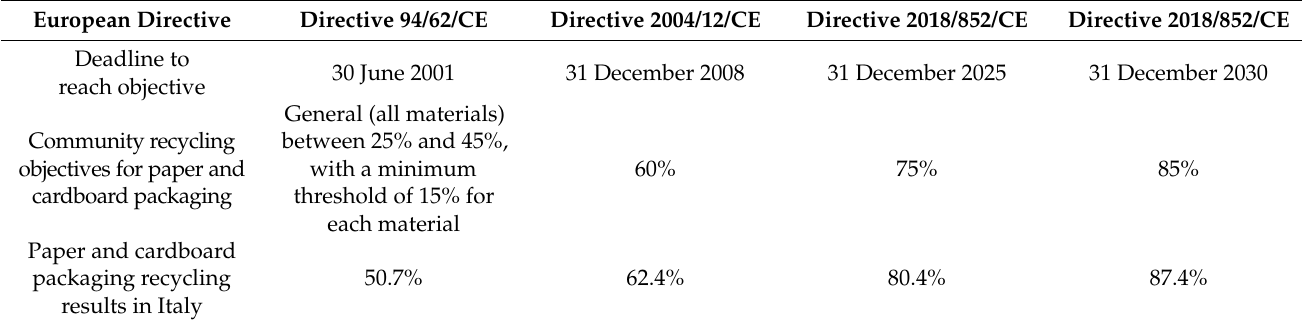
Table 1. European recycling objectives achieved and to be reached (Adapted from COMIECO,